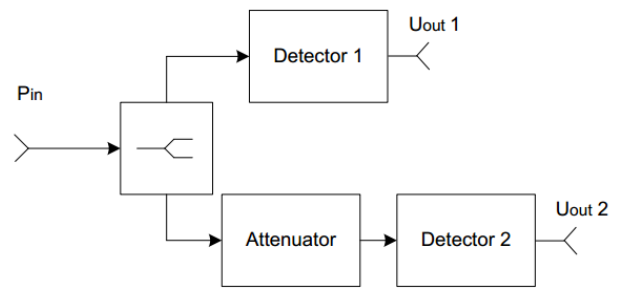
Fig. 1. Two-path detector block diagram.